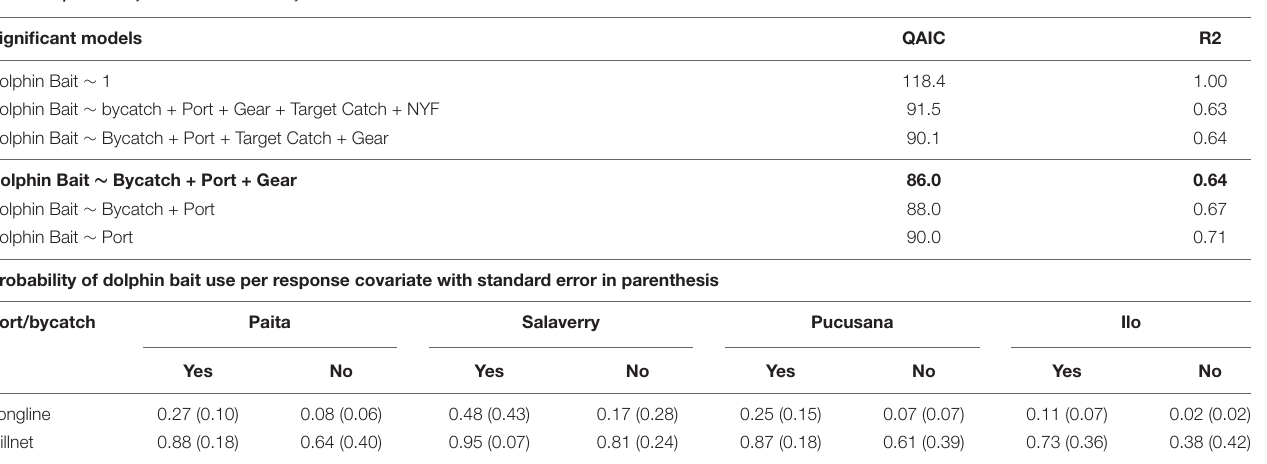
Skin and muscle from flanks